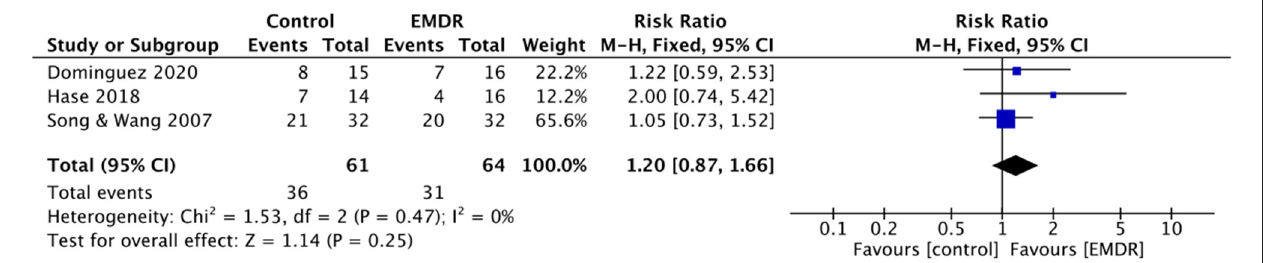
FIGURE 6 | Forest plots of meta-analyses EMDR vs. CBT group on severity of MDD. EMDR, eye movement desensitization and reprocessing. CBT, cognitive behavioral therapy. MDD, major depressive disorder.